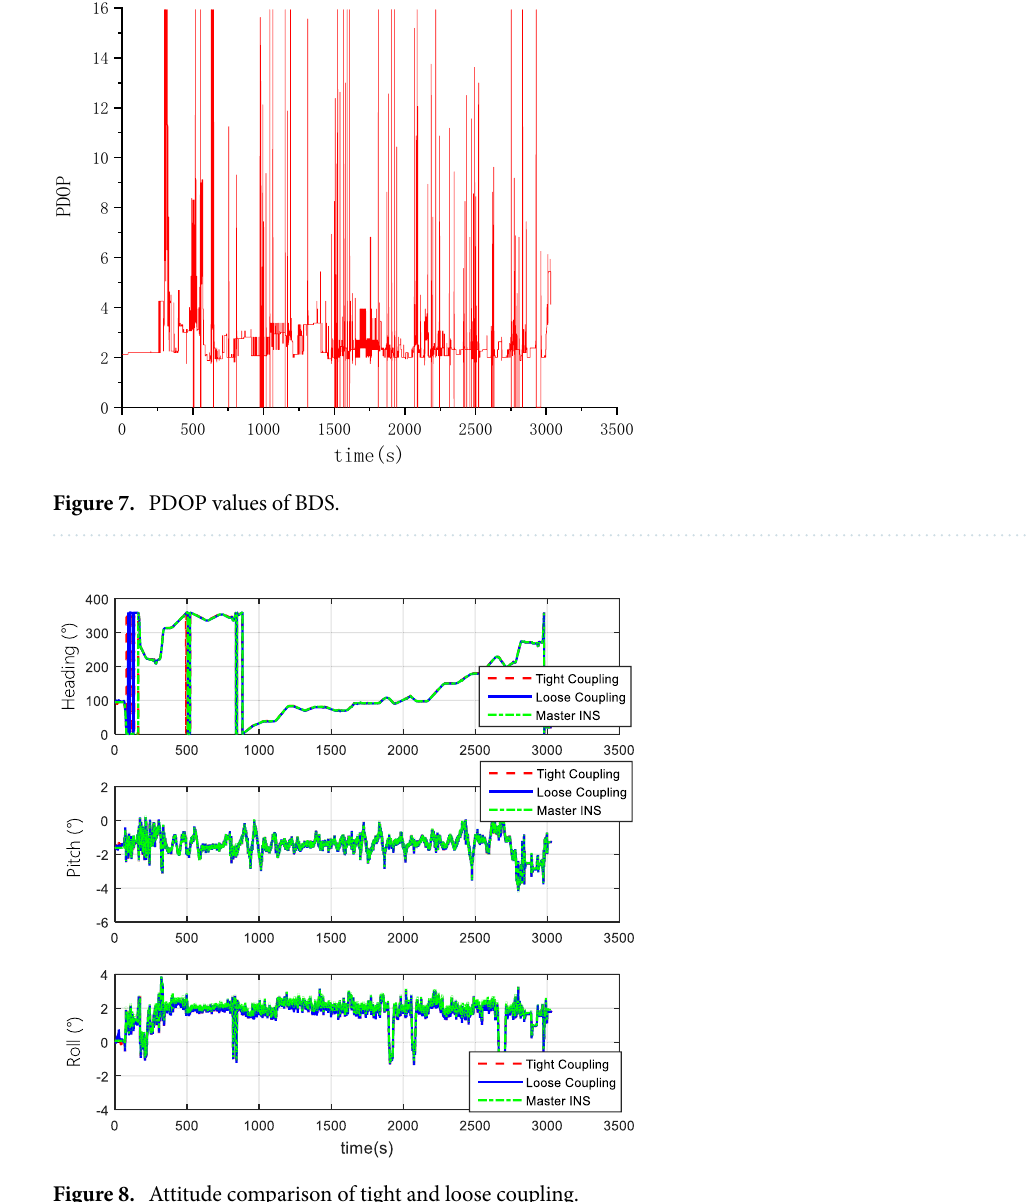
Figure 8. Attitude comparison of tight and loose